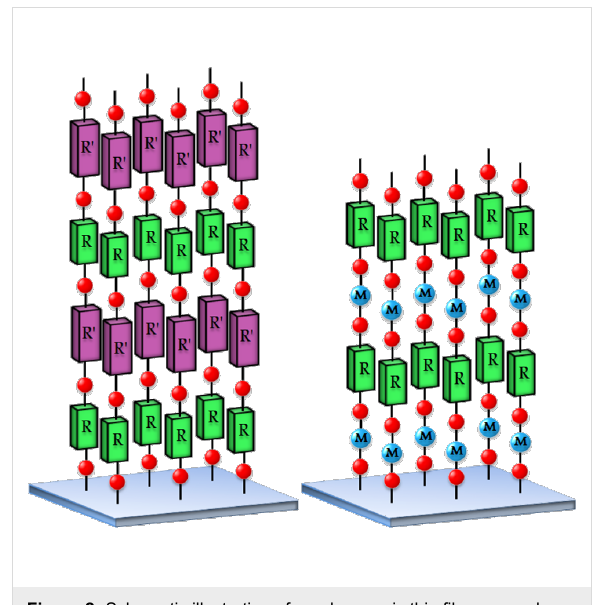
Figure 2: Schematic illustration of purely organic thin films grown by MLD (left) and hybrid inorganic–organic thin films grown by ALD/MLD